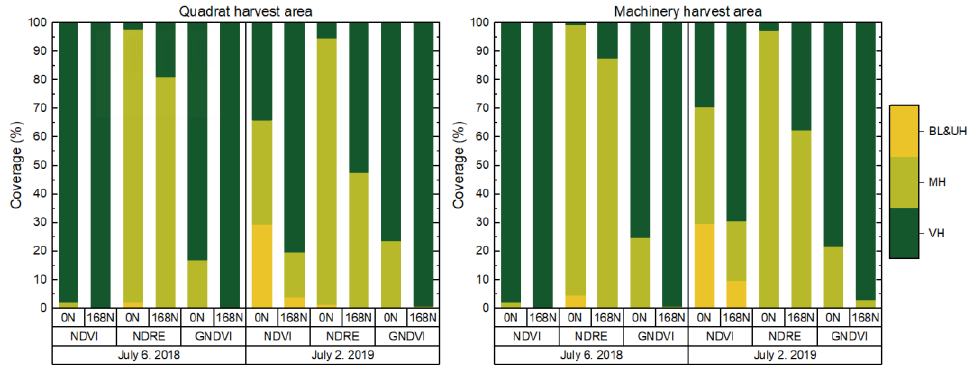
Figure 6. Vegetative indices in early growing season show differences in stand health between the lowest (0 N kg ha −1 ) and highest (168 N kg ha −1 ) N treatments in 2018 and 2019. The darker color indicates very healthy (VH) stands.